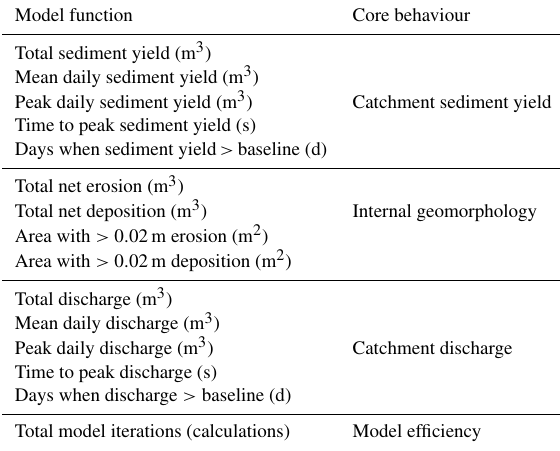
Table 2. Model functions and the associated core